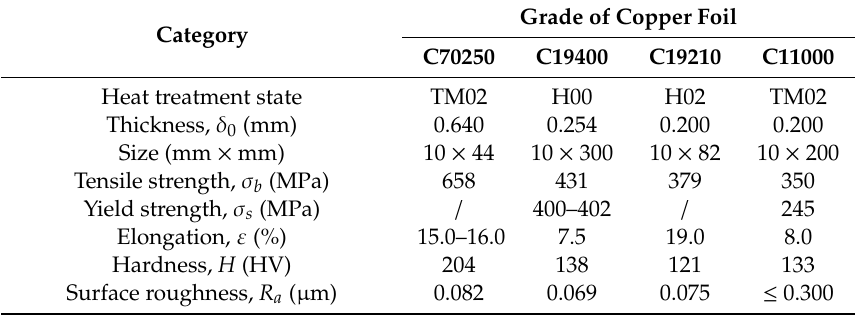
Table 2. Chemical compositions of copper foils used in experiments. Table 1. Dimensions and mechanical properties of copper foils used in